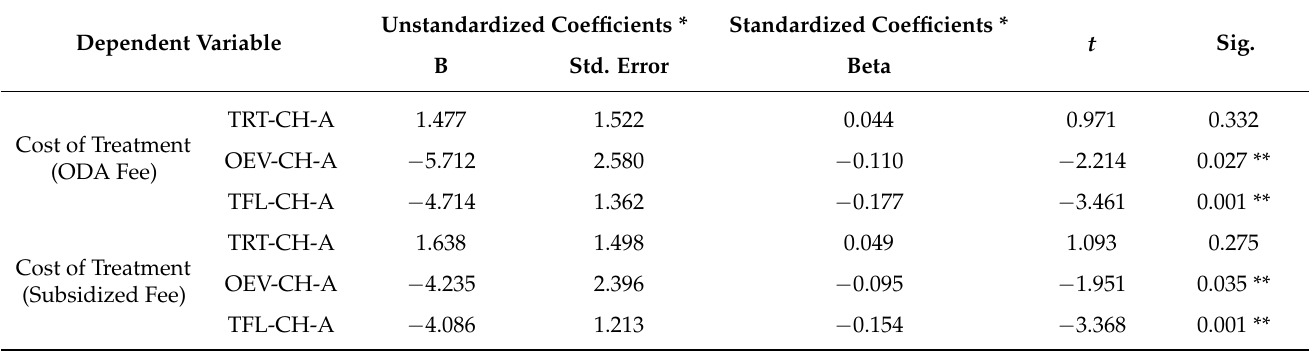
Individual-level linear regression with median income as the dependent variable found that individual-level regression modelling showed that the utilization of treatment (TRT-CH-A) did not have a significant association with the cost of treatment when either the cost of treatment or subsidized treatment were used as dependent variables (Table 2). In contrast, both oral evaluation ( β = − 0.110, p = 0.027) and topical fluoride applica- tion ( β = − 0.177, p = 0.001) had a significant negative association with cost of treatment when the suggested fee guide was used. The associations remained valid even when the subsidized value was used as the dependent variable (Table 2). Table 2. Individual-level association between outcome measures and cost of treatment and median household income.